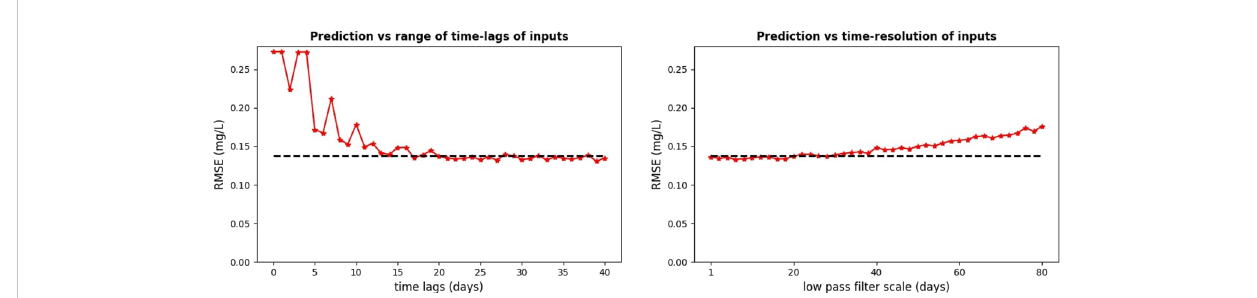
FIGURE 7 The necessary time-lags in the SST inputs (left-hand panel) and the required time-resolution of the input data (right-hand panel). The RMSE values on the y-axis of the left-hand panel are shown for simulations using in their inputs always the full range of time-lags from the zero time-lag to maximum time-lags corresponding to the values on the x-axis. The analysis is for MLP NN model at the GB location.